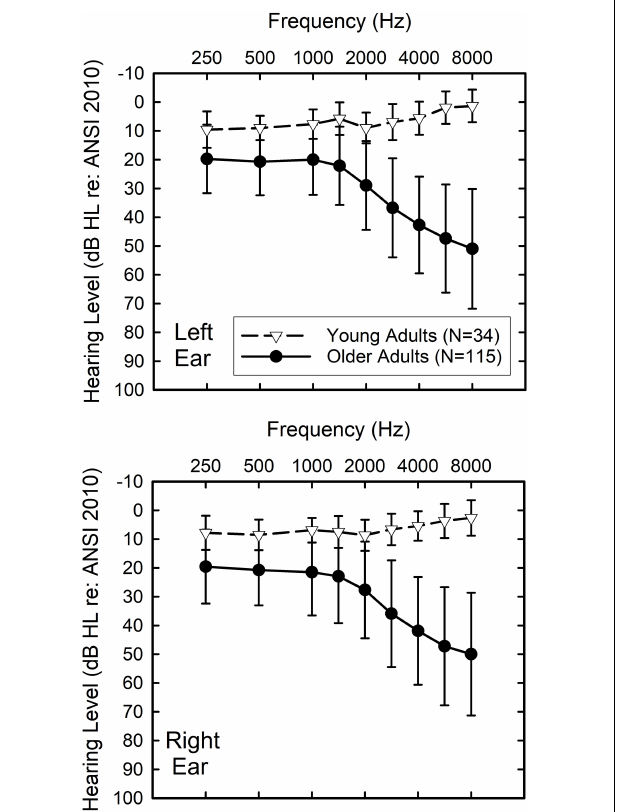
FIGURE 1 | Means and standard deviations for the air-conduction pure-tone thresholds from the audiogram for young (triangles) and older (circles) adults and the left (top) and right (bottom)